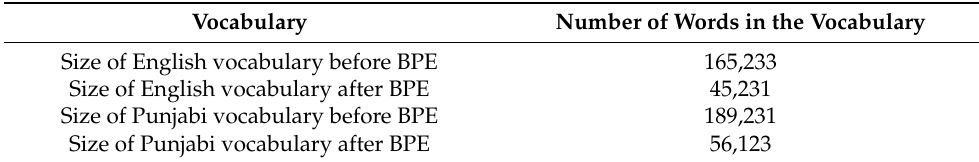
Table 7. The Size of Vocabulary with the use of BPE.